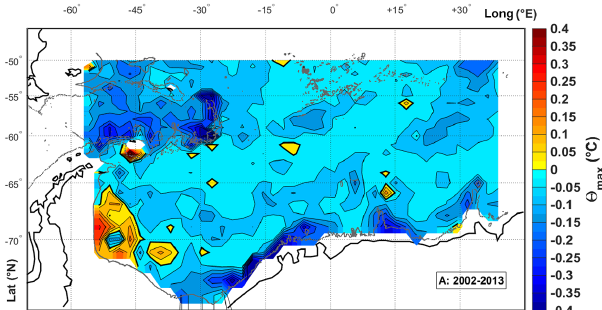
Figure 15. Comparing methods of mapping the sub-surface tem- perature maximum: this map shows the temperature difference ( ◦ C) where the output in the first approach in Fig. 11b is subtracted from the output of the second approach in Fig. 14a. Bold contour lines at 0 ◦ C. The grey contour shows the 2000m isobath.